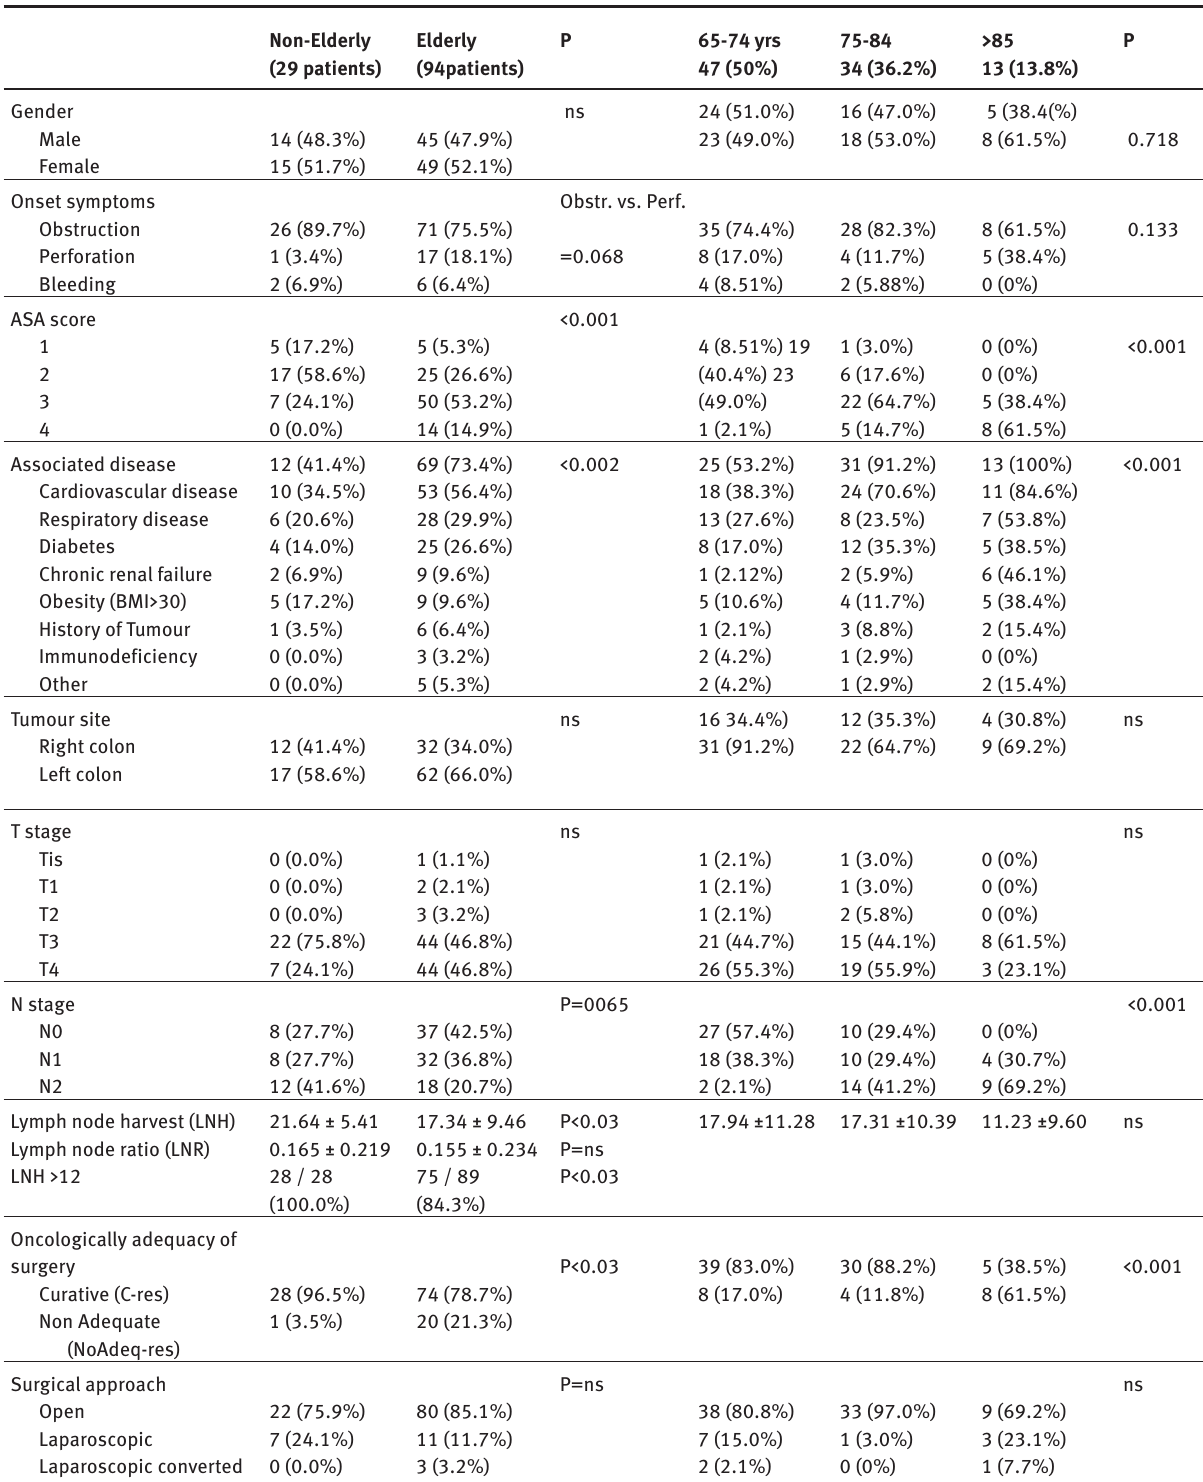
Table 1: Patients’ demographics and clinical